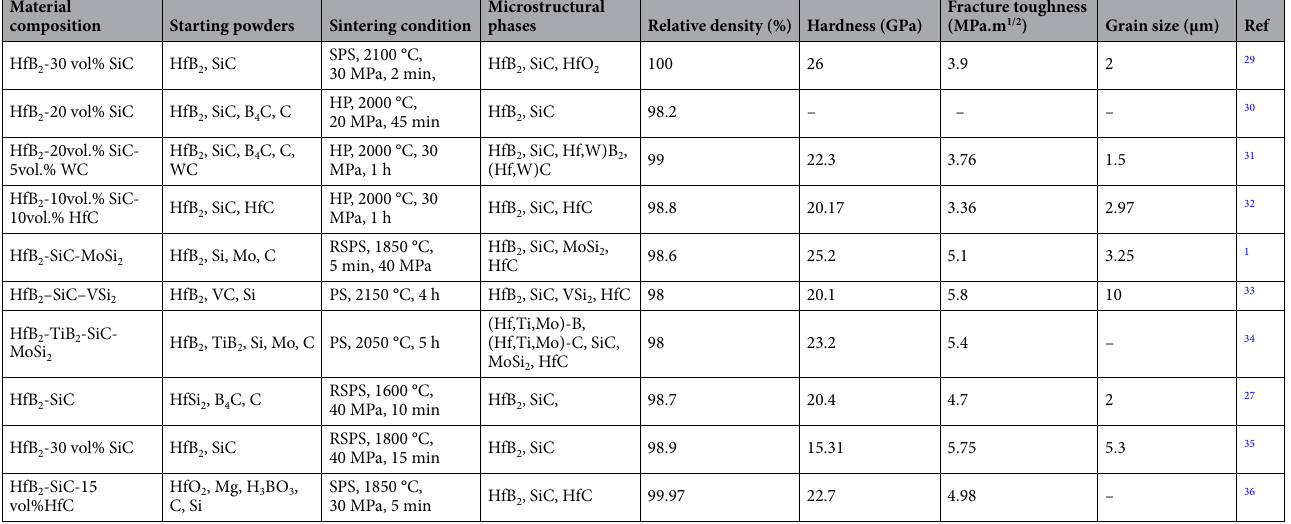
Table 1. Preparation conditions and properties of SiC reinforced HfB 2 -based composites.